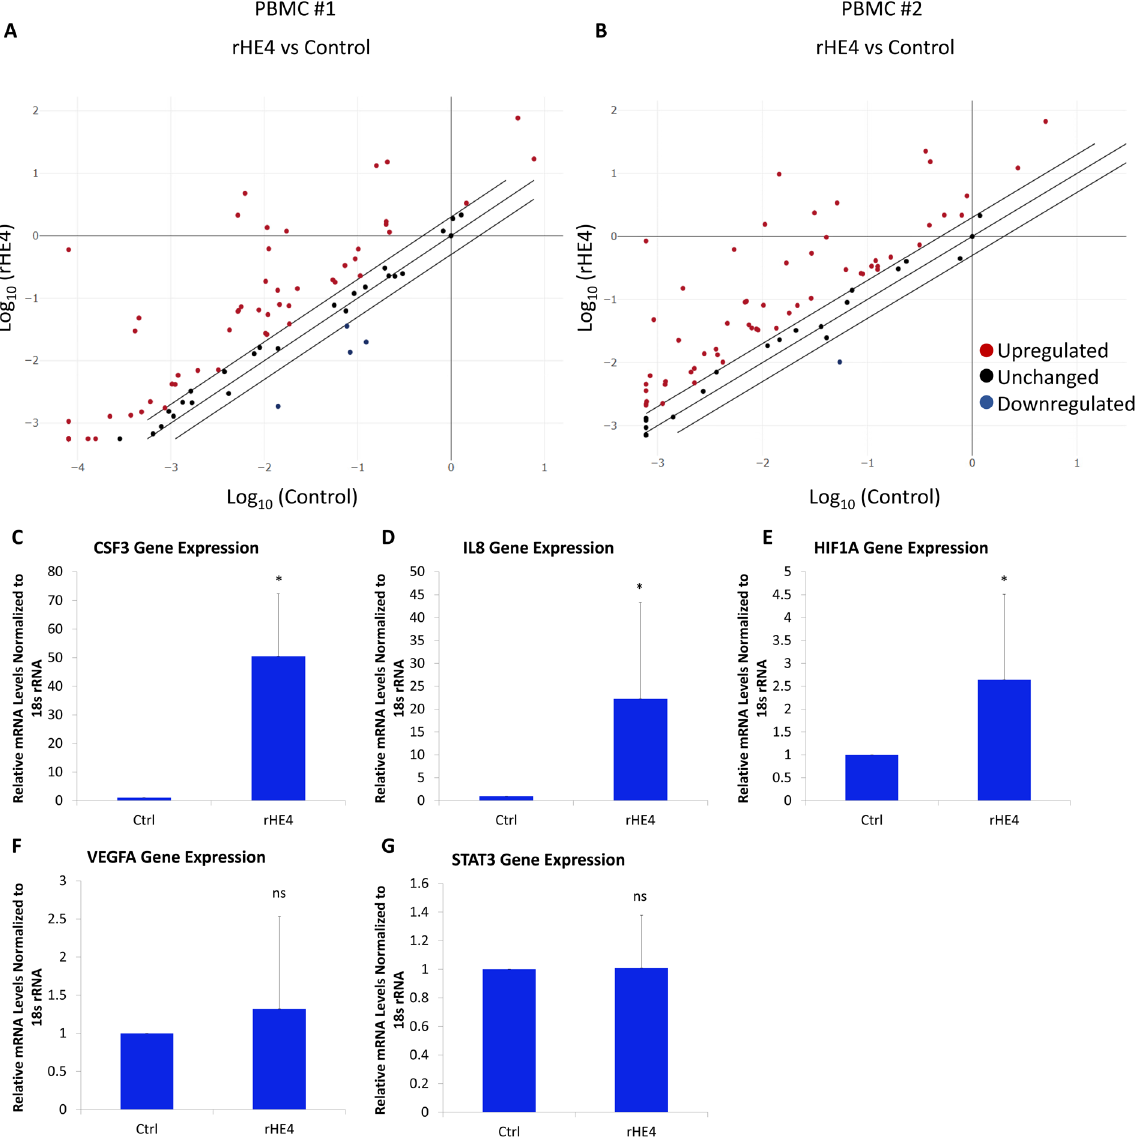
Figure 1. HE4 regulates immune-related gene expression in peripheral blood mononuclear cells ( A,B ) Scatter plots of gene expression determined by quantitative PCR array in control or rHE4-treated PBMC. qPCR was performed to validate genes changes, revealing upregulation of CSF3 , IL8 , and HIF1A with rHE4 treatment of PBMC (C–E) . No change in STAT3 or VEGFA levels were observed with rHE4 treatment (F,G) . Error bars represent standard deviation. * p < 0.05. Results are the average of at least three biological